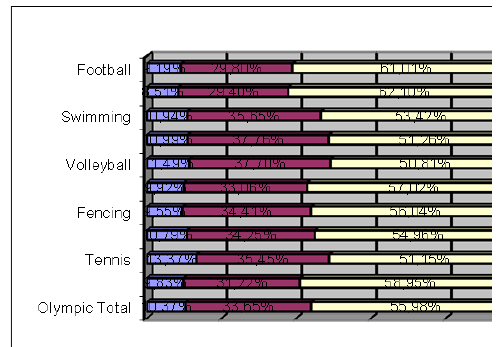
Figure 17: TV Audience for the Olympics, by Sport in Italy. Viewers by Age (in Percentages). Year